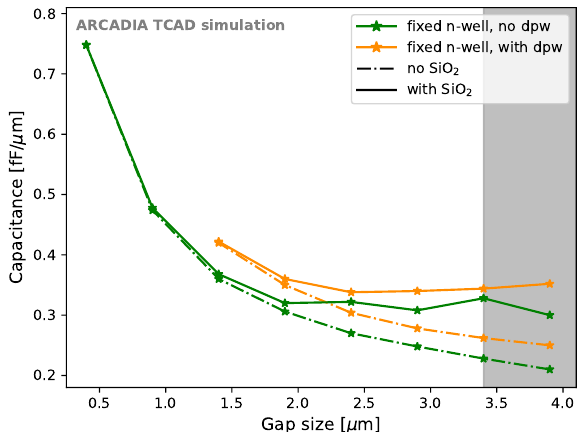
Figure 17. Sensor capacitance C sens as a function of the gap size for different sensor layout configura- tions with and without the deep